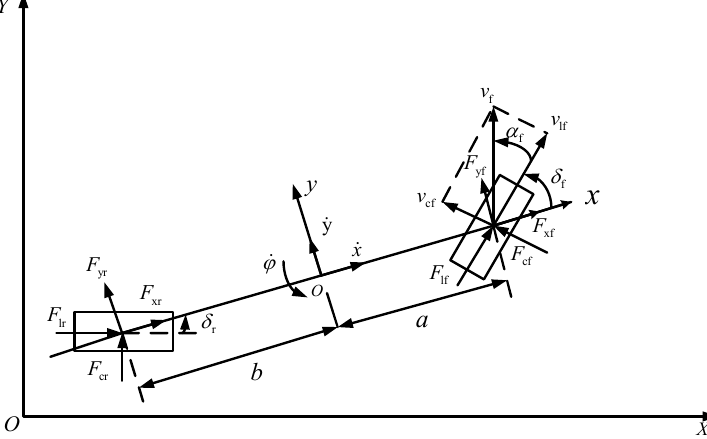
Figure 2. Vehicle dynamics model. Longitudinal force of the vehicle in the X -axis direction: